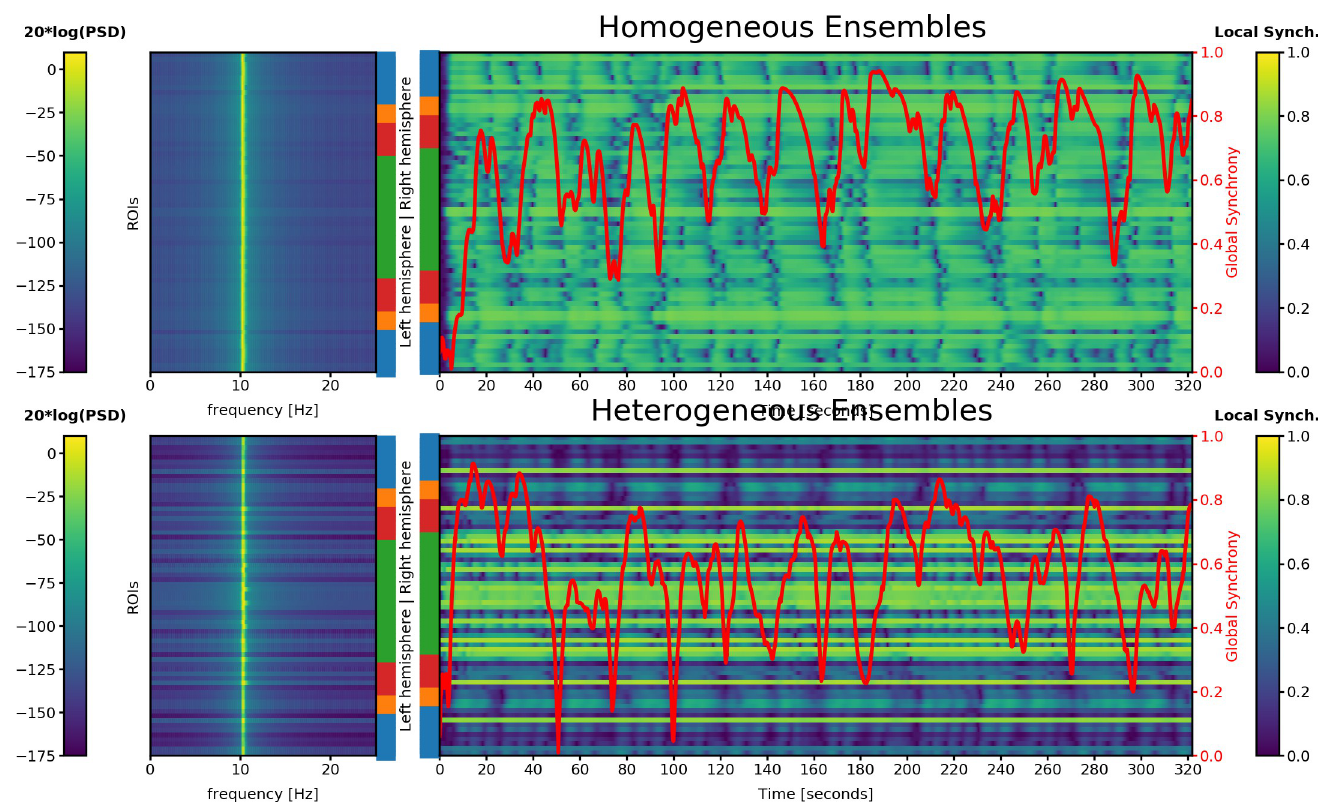
Fig 4. Power spectral density (PSD) and temporal evolution of local synchrony in each ensemble, overlaid with the level of global synchrony. Top: LSBM with homogeneous ensembles; Bottom: LSBM with heterogeneous ensembles. Each horizontal line reflects the ensemble that represents one brain region. The lobes are color-coded using the same conventions as previous figures. The left panel shows the power spectrum of the central frequency from the probability density of frequencies. The right panel shows the temporal evolution of local (within-ensemble) synchrony in yellow-blue color. The global synchrony (between-ensembles) is represented in red (right,